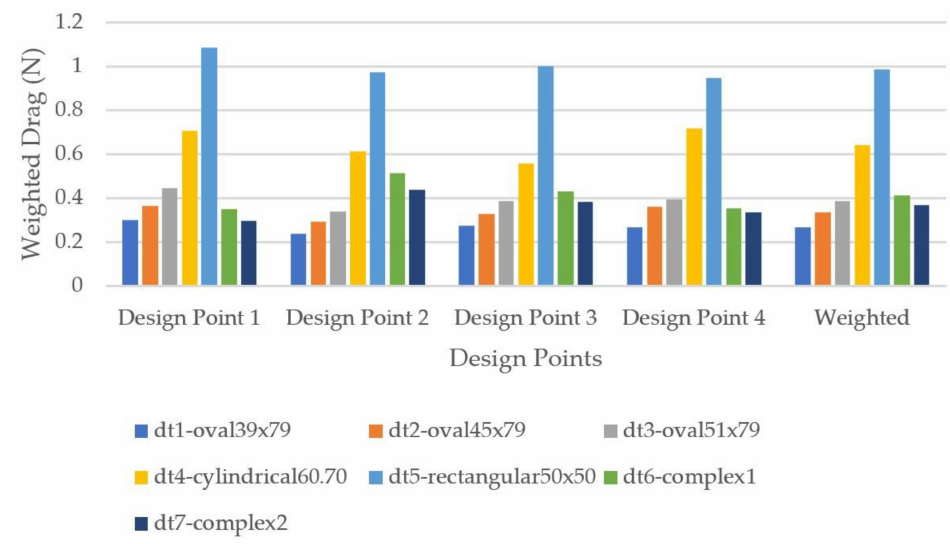
Figure 27. Weighted drag force on down tube cross-sections.